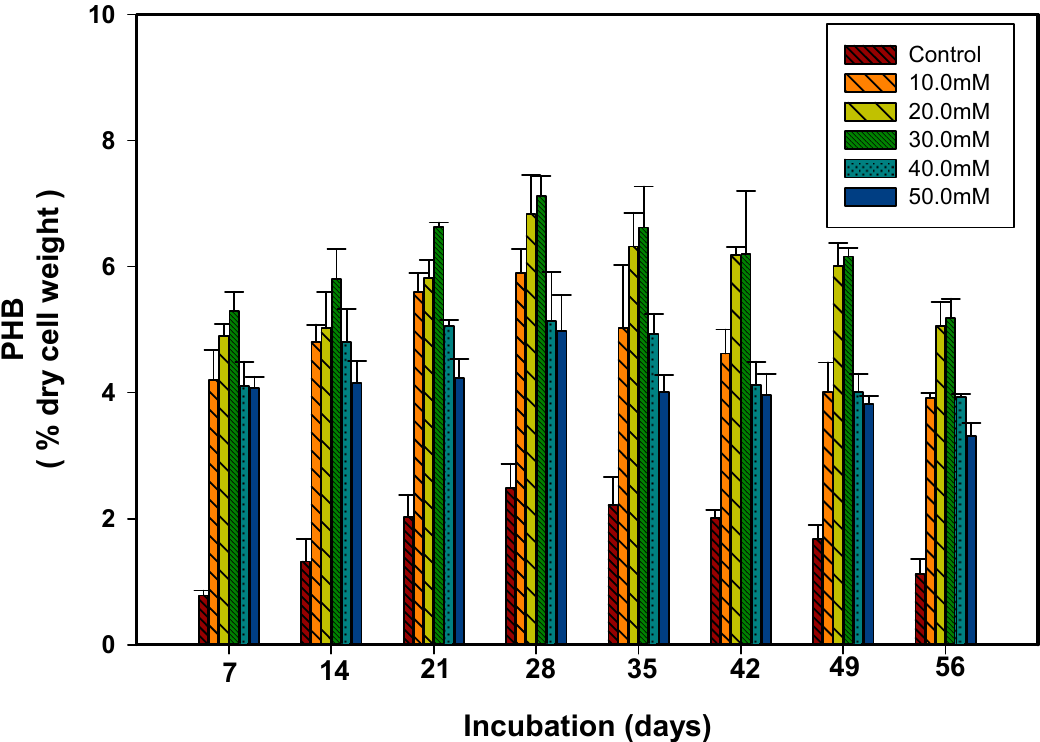
Figure 4. Production of PHB in S. geitleri in response to acetate. Values are the mean ( n = 3) ± SD.